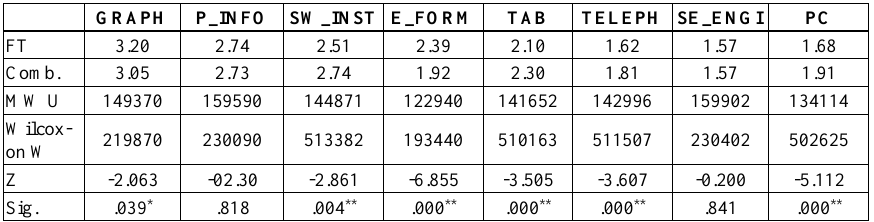
Table 7. Dependence of digital literacy on the form of study